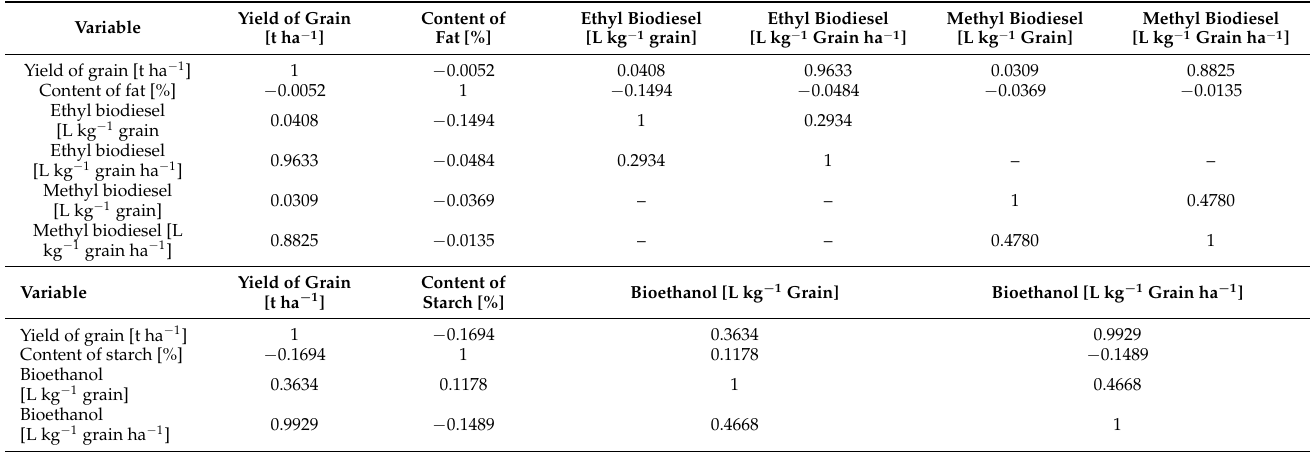
Table 4. Correlation analysis of results for bioethanol.